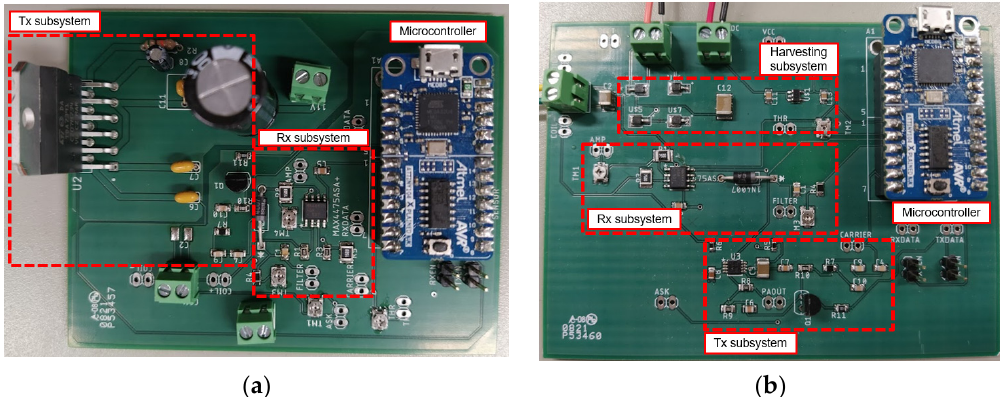
Figure 17. Built prototypes for wireless power transfer through metal communication system: ( a ) outside, and ( b ) inside subsystems.